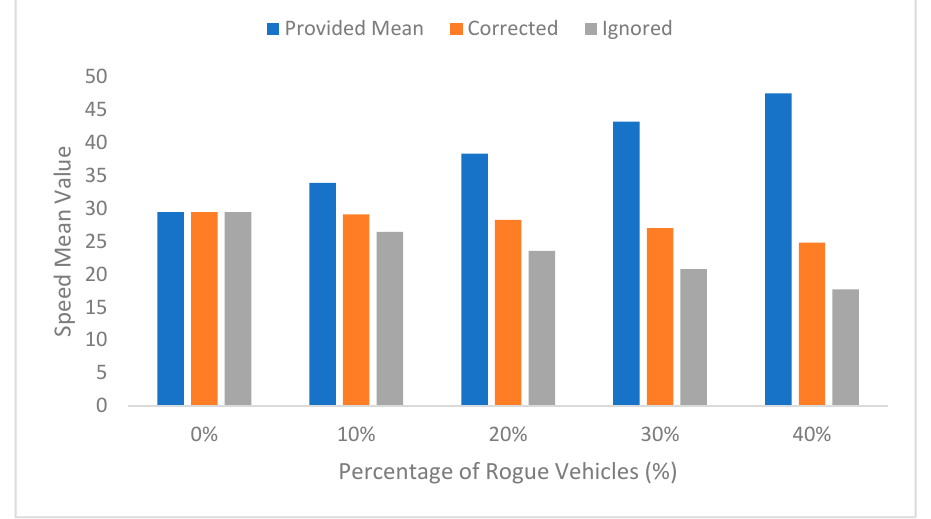
Figure 6. Varying of the speed mean value.